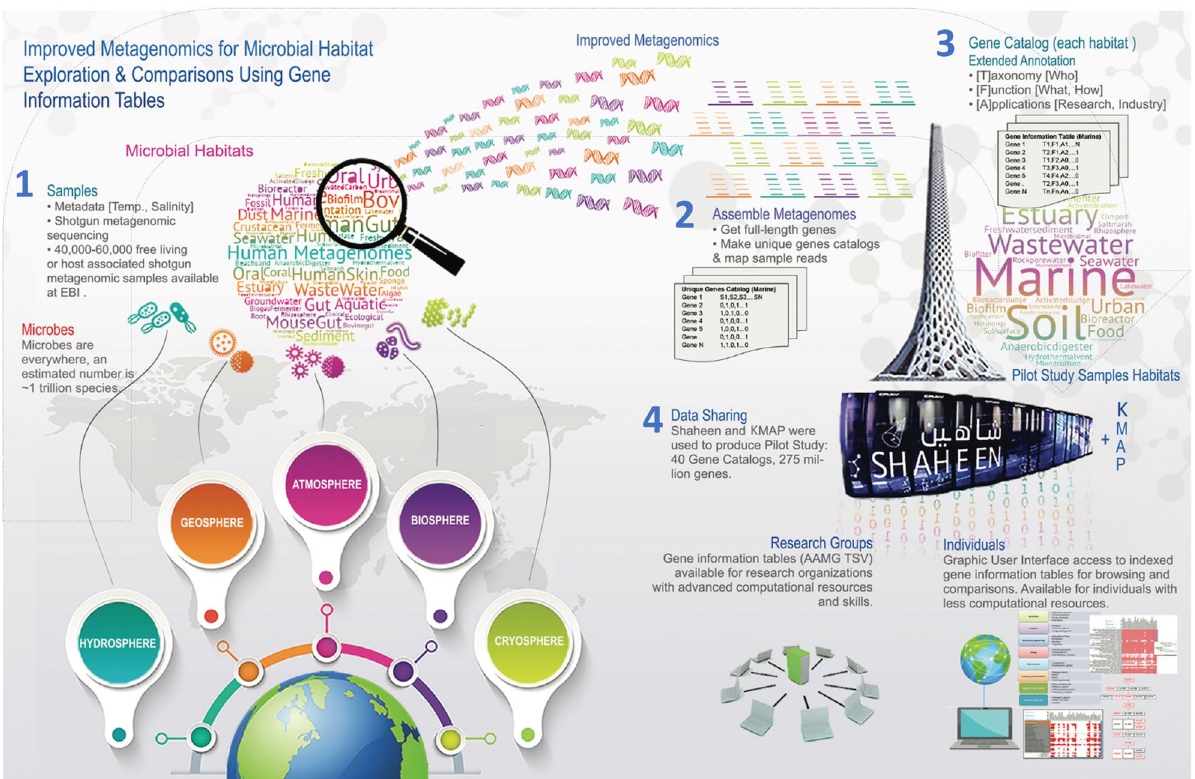
Figure 1. A summary of the KAUST Metagenomic Analysis Platform (KMAP) concept is as follows: (1) utilize existing short reads-based samples from European Nucleotide Archive (ENA), (2) improve shotgun metagenomic analysis through assembly and organization of full-length (complete) genes into habitat-specific gene catalogs (see pilot studies), and (3) extending and improving annotations of gene catalogs using KMAP providing Gene Information Tables (GITs) useful for data sharing with research groups for further computing intensive command-line analyses or individuals with fewer computational resources. Example gene catalogs reported in this study are shown in Supplementary Table